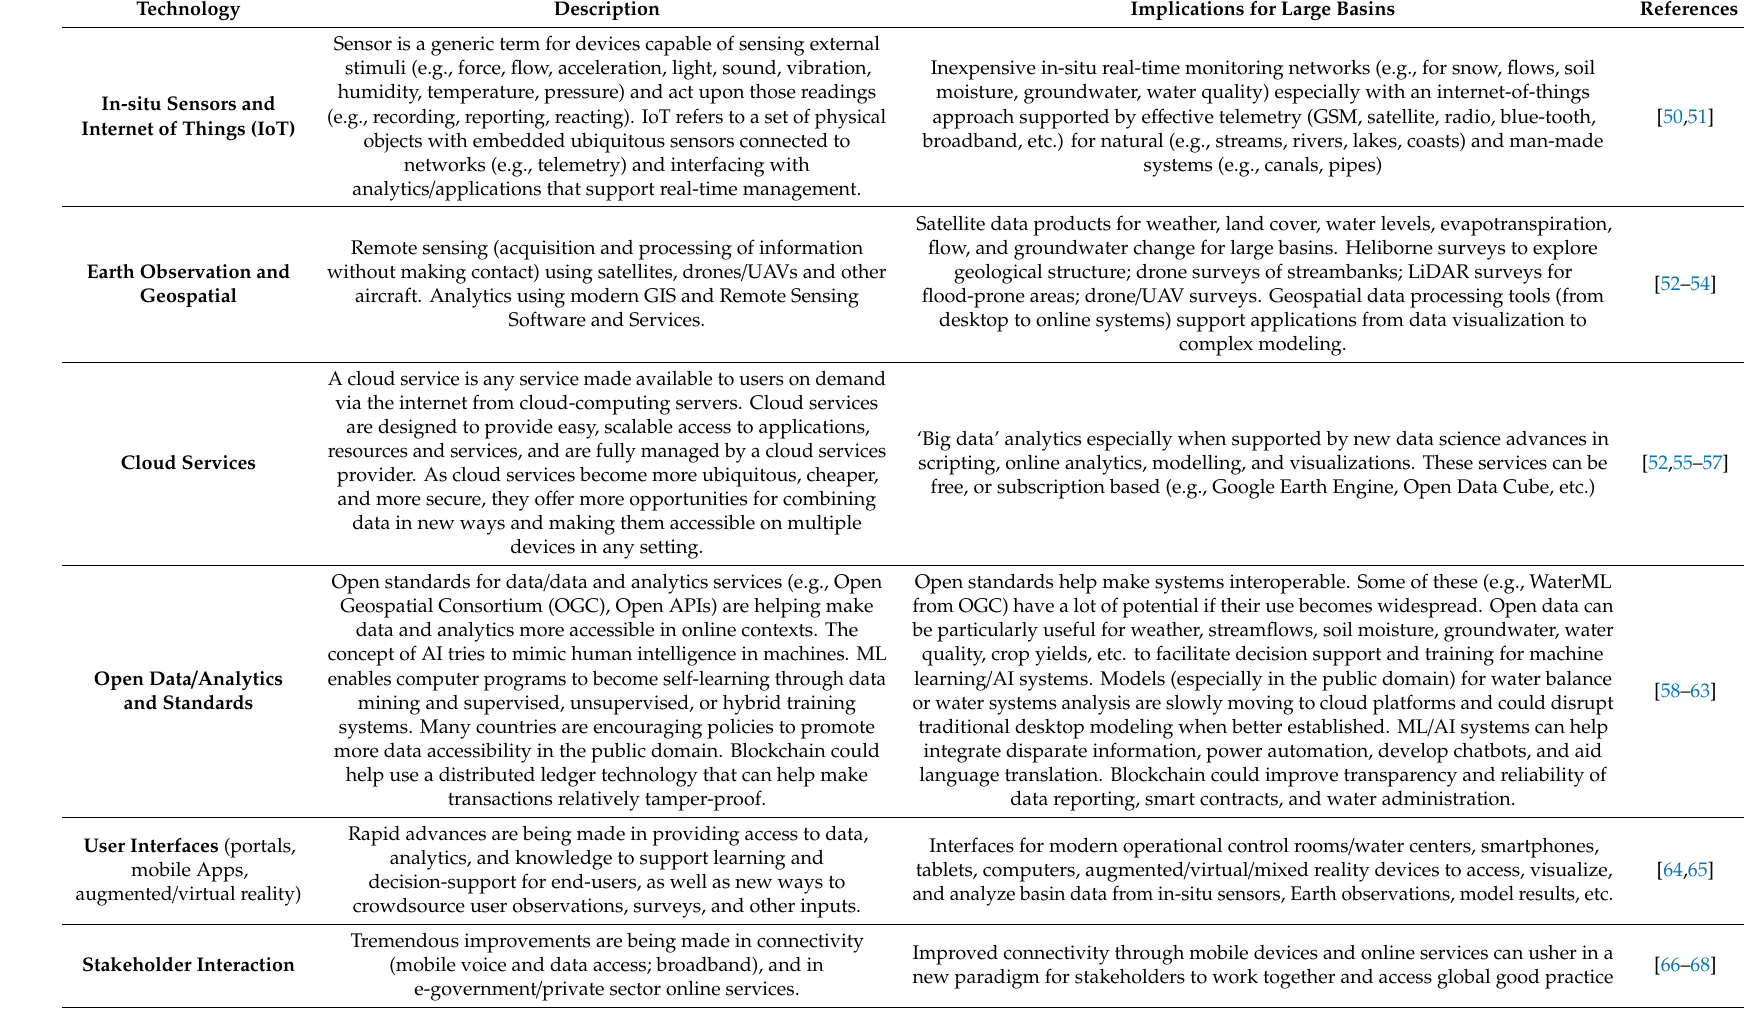
Table 1. Summary of disruptive technologies relevant to water management in large